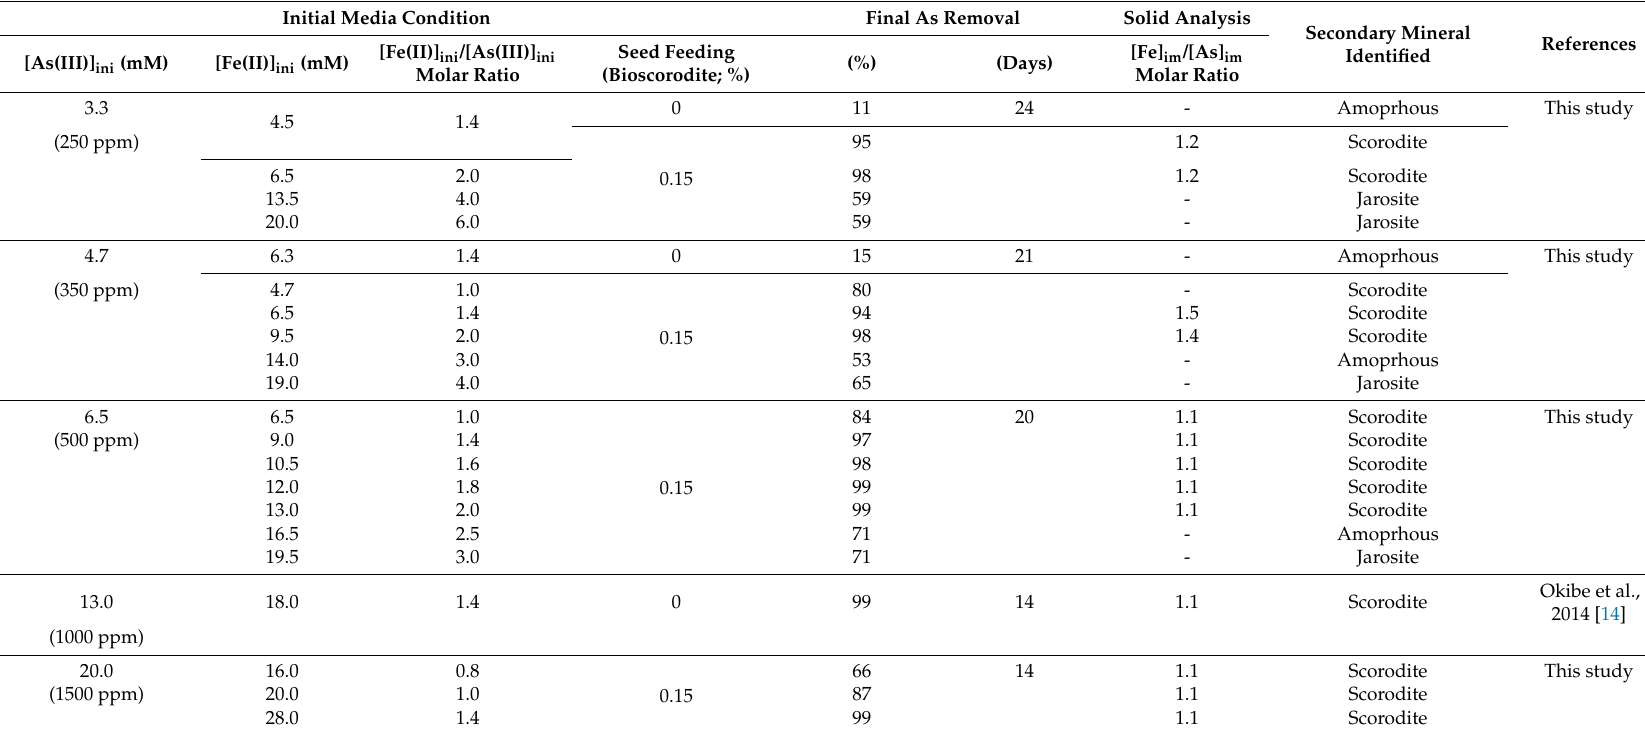
Table 3. Evaluation of [As(III)] ini and [Fe(II)] ini /[As(III)] ini molar ratios for final As removal as bioscorodite (pH 1.5; with or without bioscorodite seed